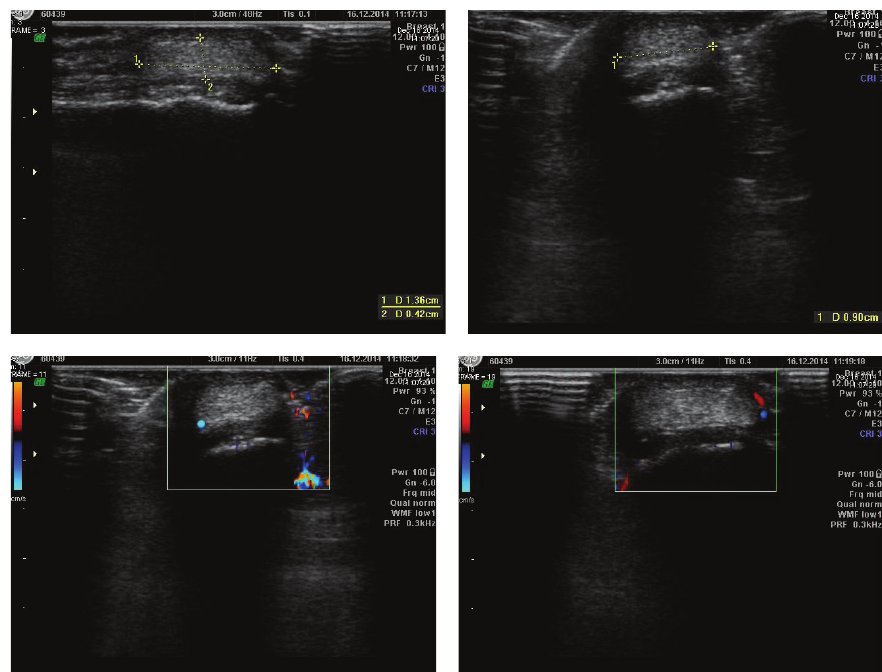
Figure 1: Ultrasound of the ulnar aspect of the thumb showing a well defined mildly hyperechoic lesion measuring 1.36 ∗ 0.42 ∗ 0.9 cm abutting the ulnar collateral ligament, which is otherwise intact. No internal flow was seen on